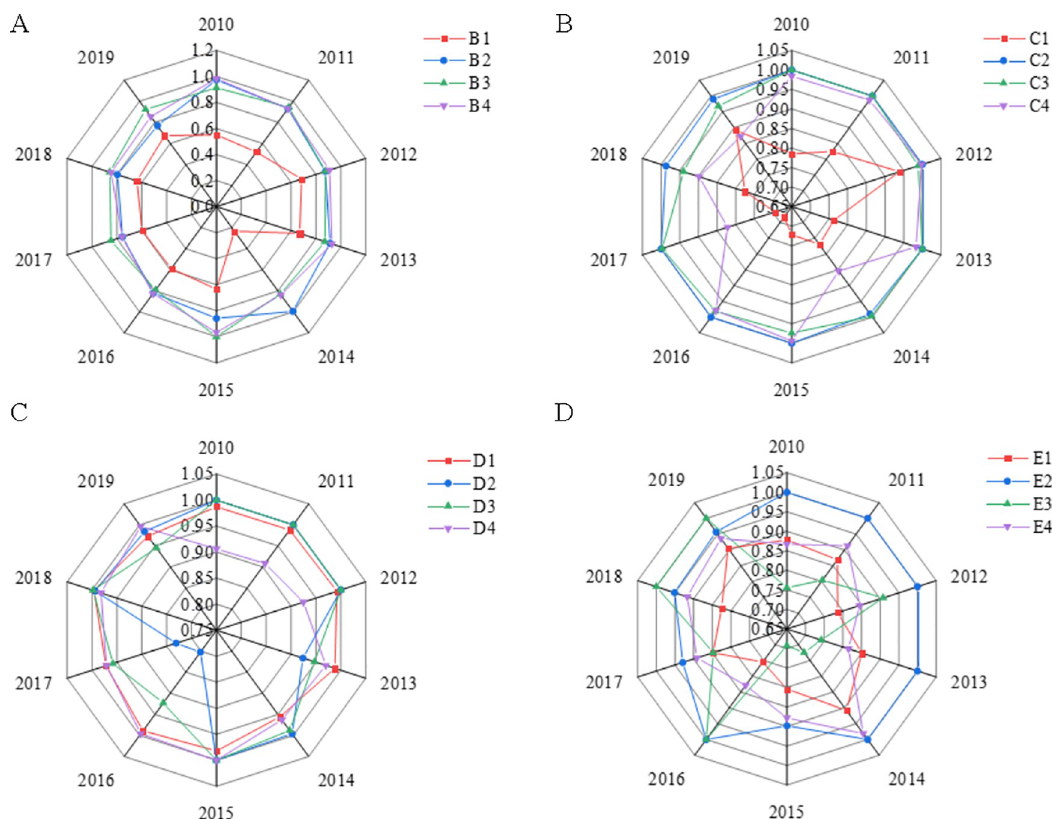
Fig 8. Scale efficiency results of high-tech IDZs in different provinces and different years.